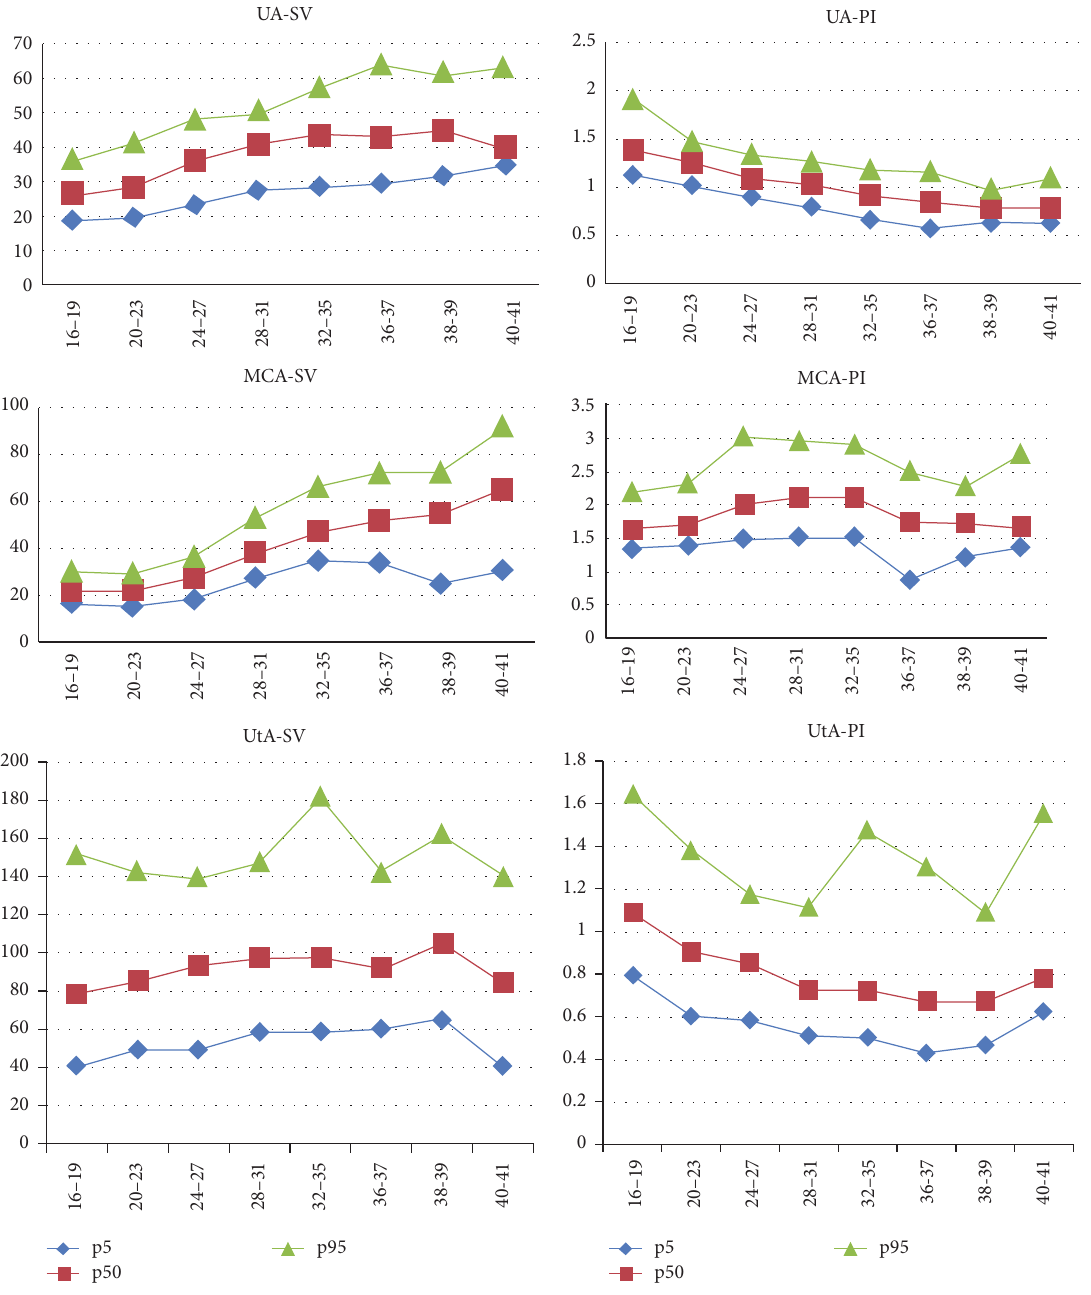
Figure 1: Longitudinal distribution of SV and PI of UA, MCA, and